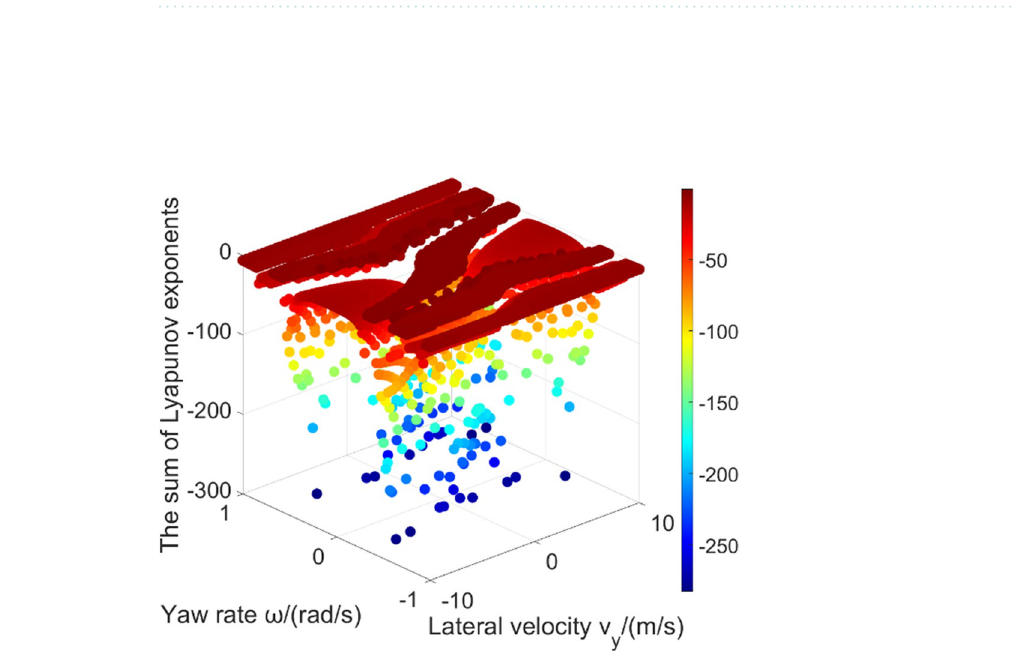
Figure 10. The sum of Lyapunov exponents in 3-DOF model global region.